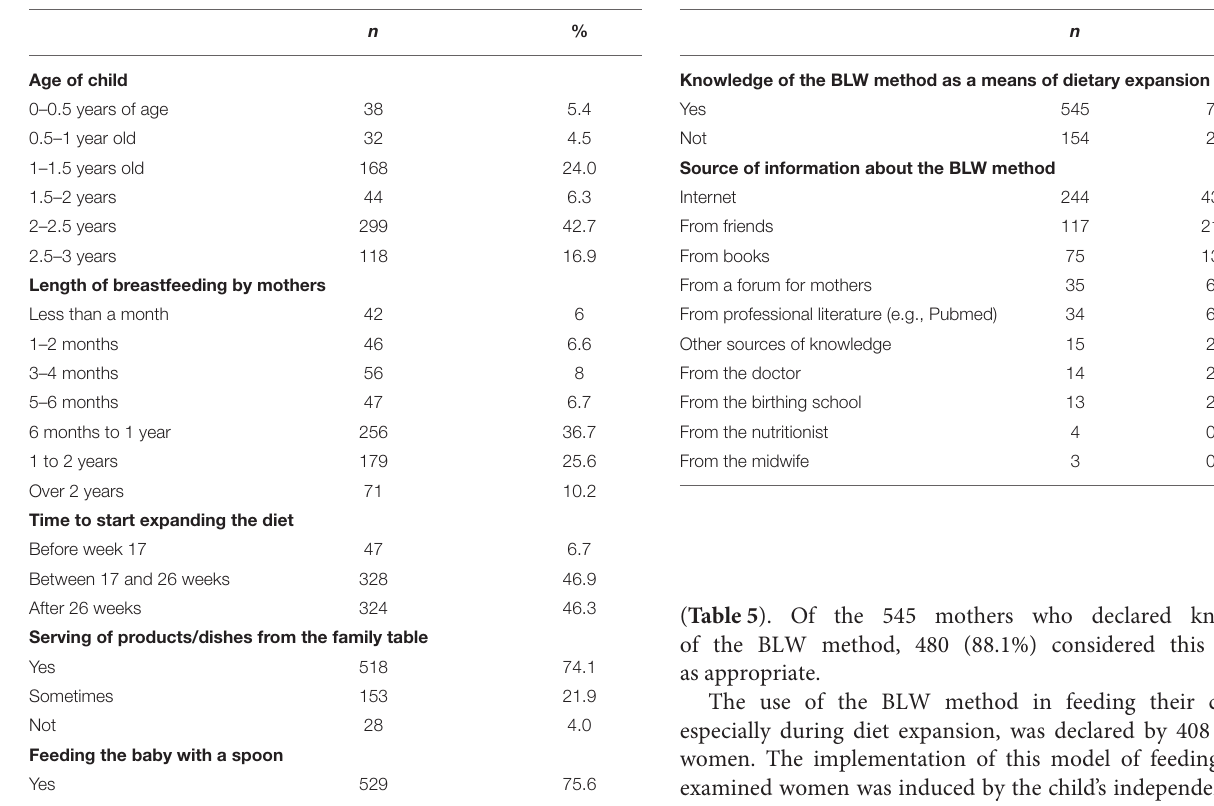
TABLE 4 | Characteristics of the studied group of children and their